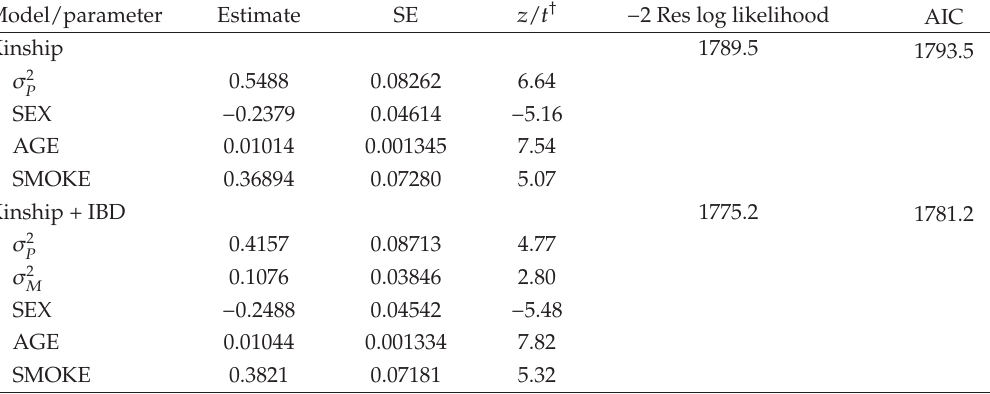
Table 2: Q1 and VEGFC under a linear model.